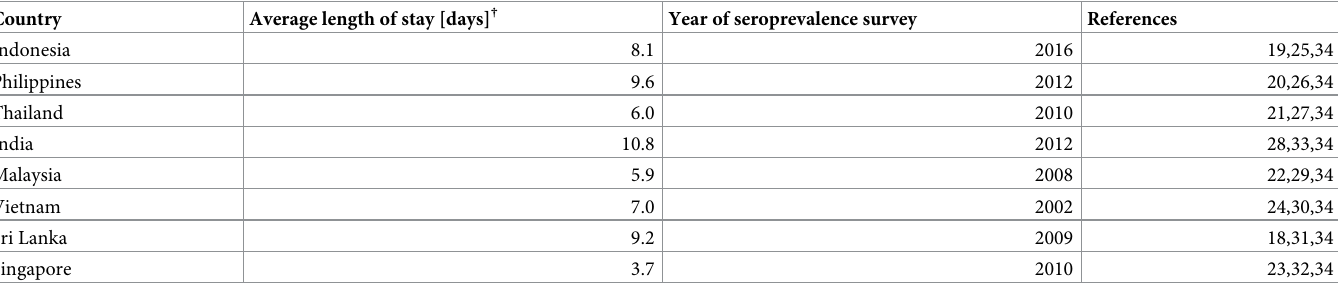
Table 1. Average length of stay among Japanese travelers and sampling year of seroepidemiological surveys in South and Southeast Asian countries. Country Average length of stay [days] † Year of seroprevalence